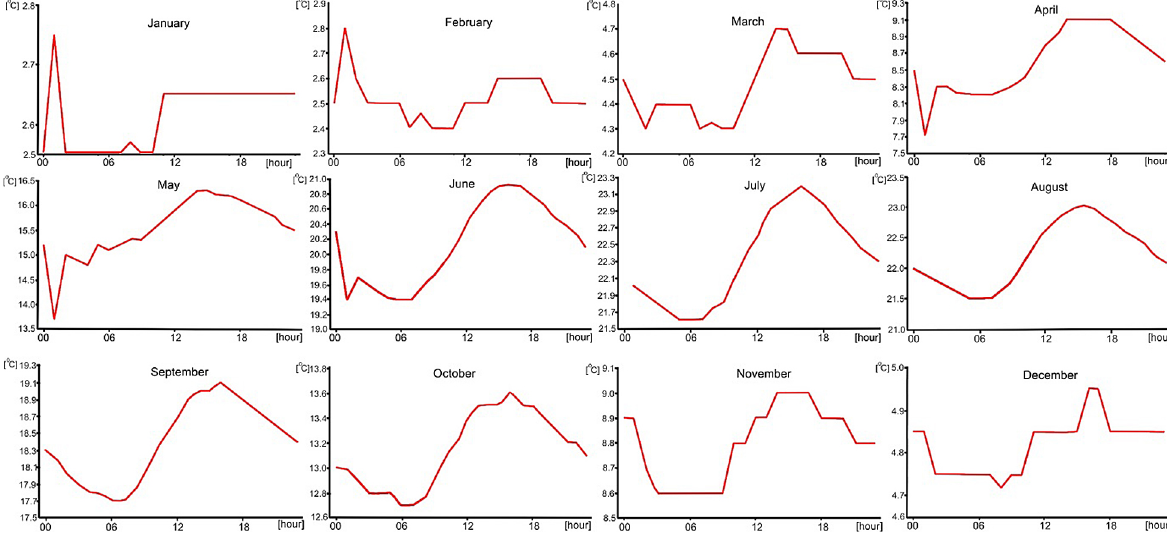
Fig. 3. Daily course of water temperature in Lake Kierskie in the monthly cycle (mean value from the years 2012–2018).